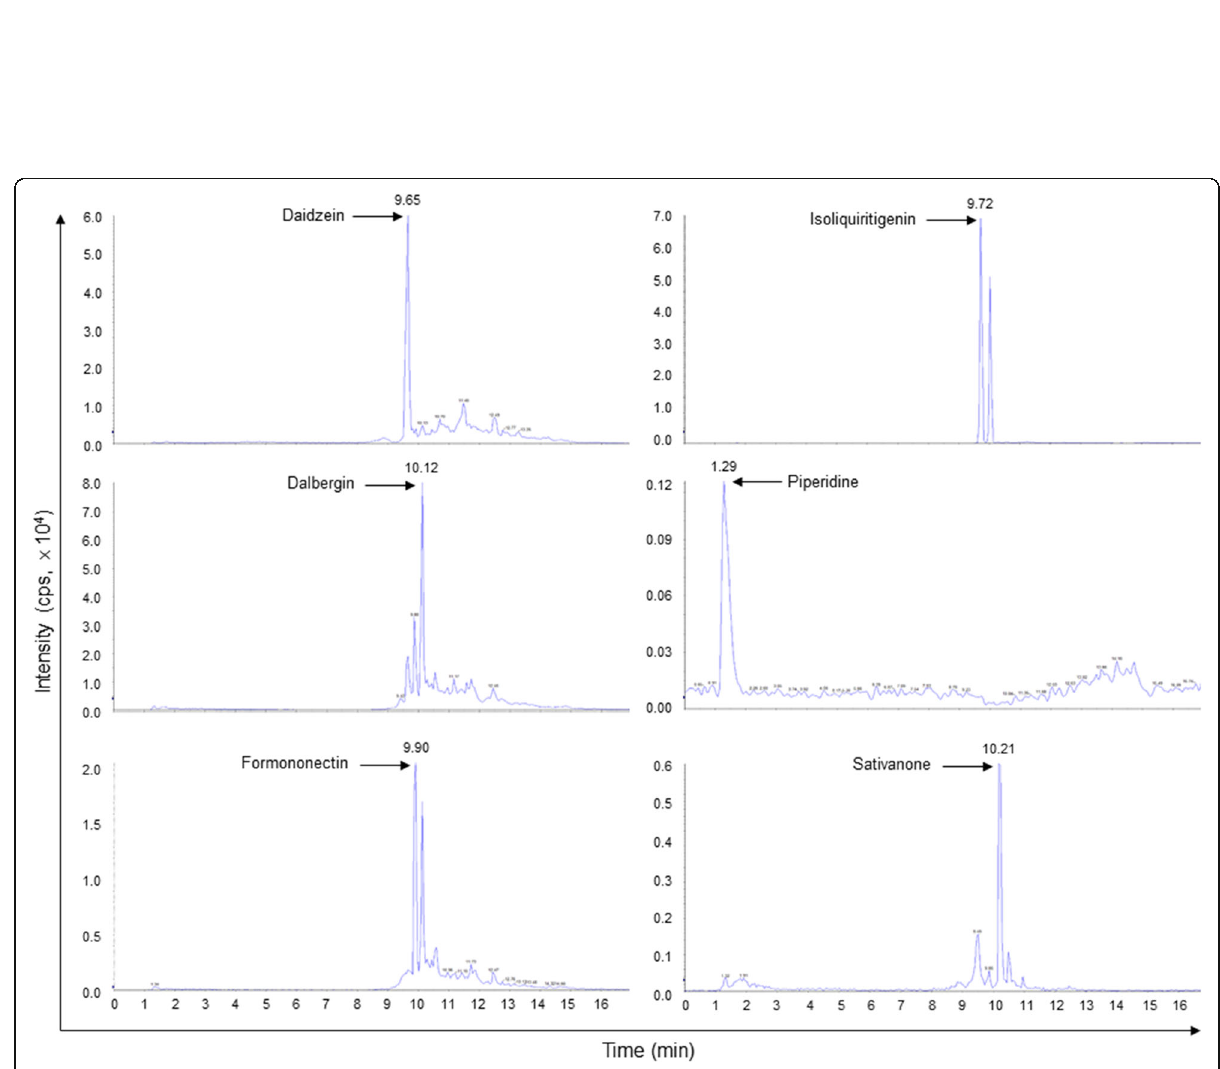
Fig. 6 LC-MS/MS analysis. Chromatographic separation was performed on a C18 analytical column eluted with an acetonitrile gradient at 0.2 ml/ min. Isoliquiritigenin, daidzein, formononetin, dalbergin, piperidine, and sativanone were identified using authentic